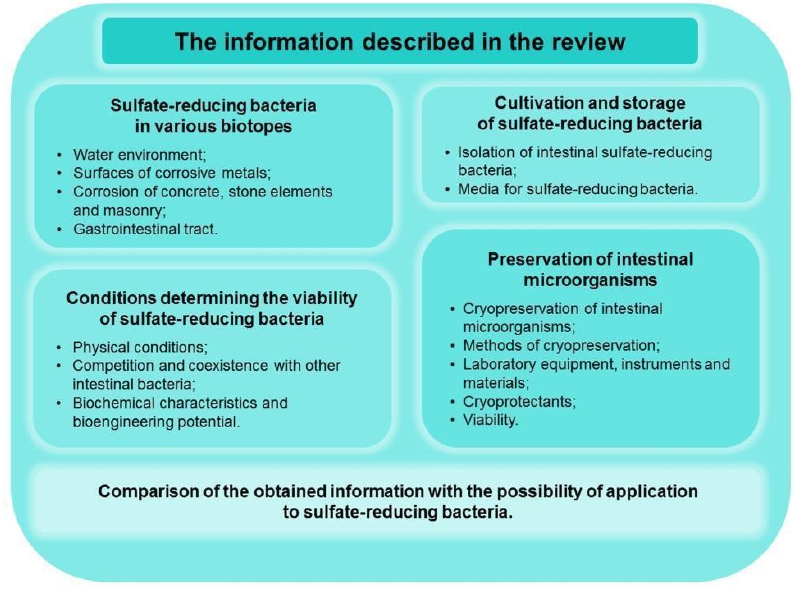
Figure 1. The scheme shows the information outlined in the